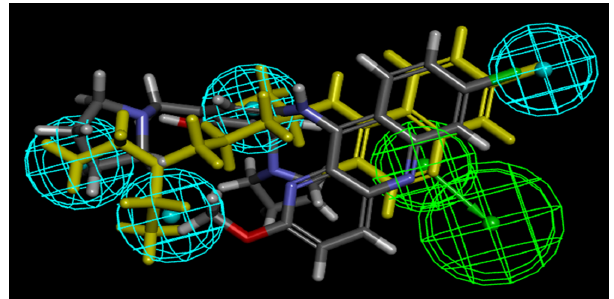
Figure 4. Pyronaridine mapped to a previously published pharmacophore based on compounds active against Ebola virus in vitro . Fit score of 3.60 (Chloroquine (yellow) = 4.21).